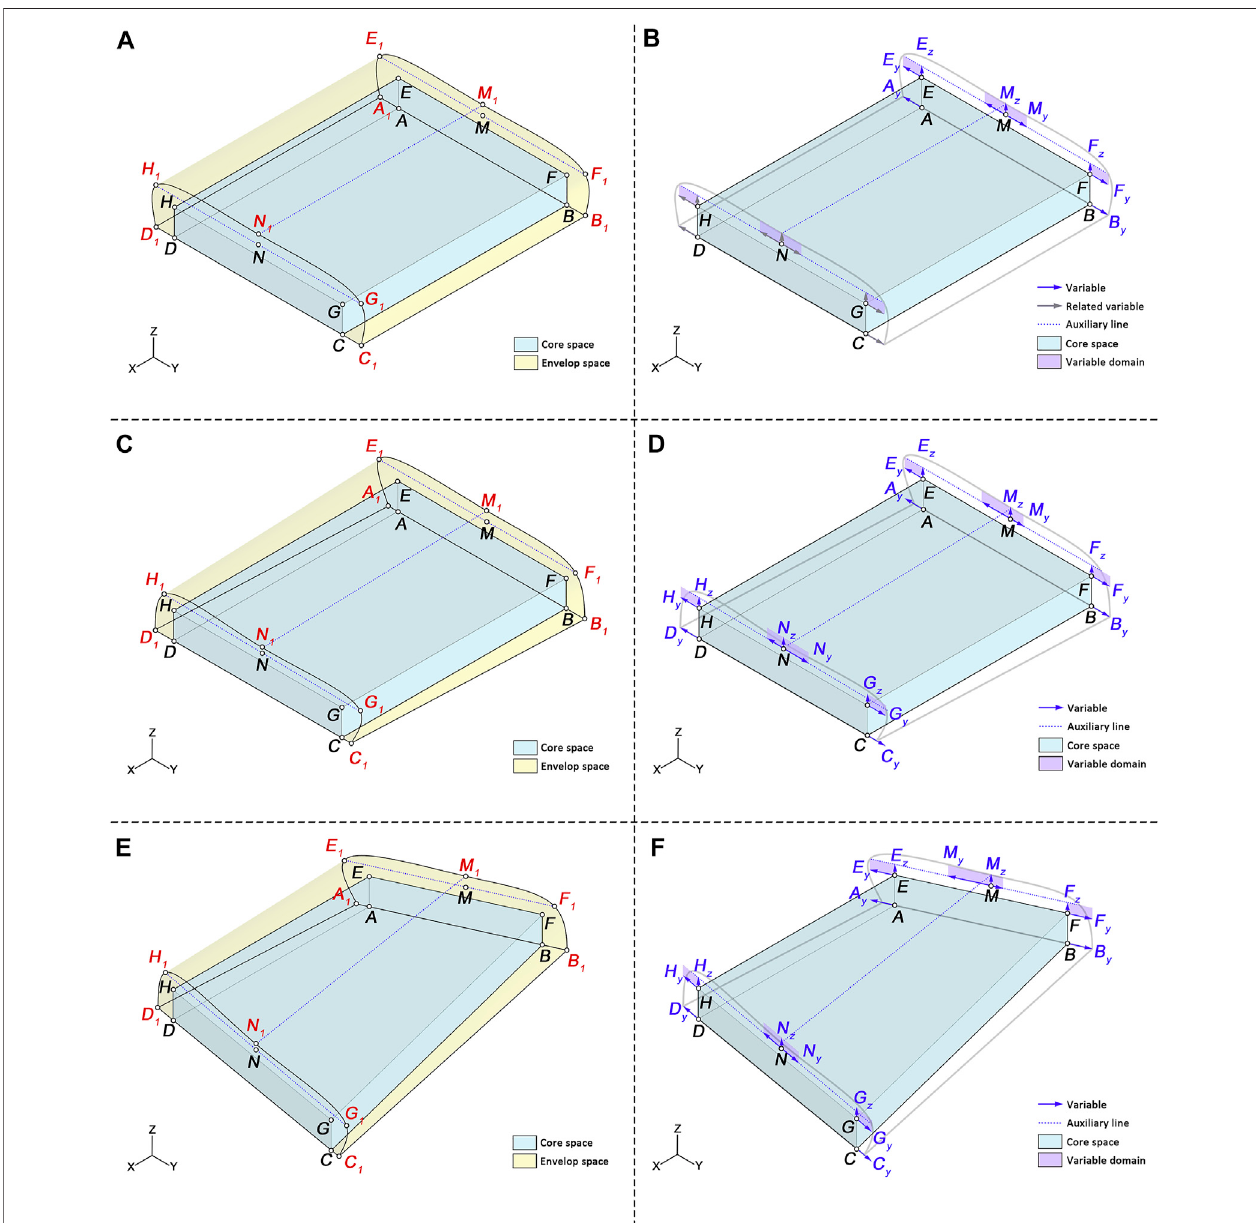
FIGURE 9 | Node systems and envelope variables of curved-edge shapes: (A) node systems of S4; (B) envelope variables of S4; (C) node systems of S5; (D) envelope variables of S5; (E) node systems of S6; (F) envelope variables of S6.